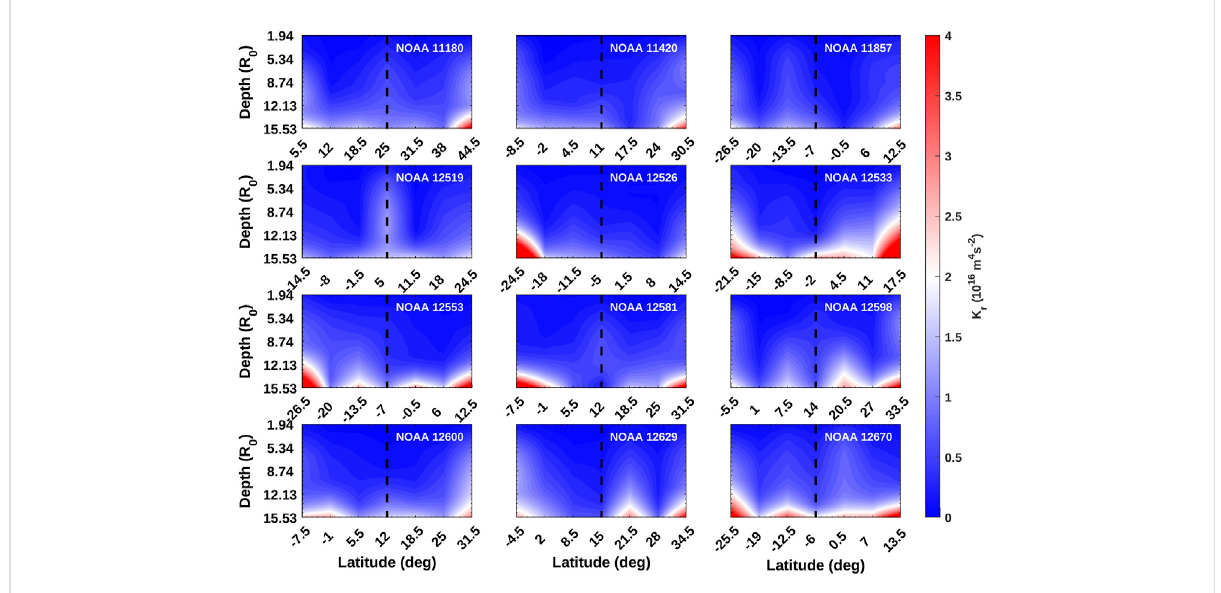
FIGURE 5 Same as Figure 4 but for non- fl aring active regions and neighboring patches.